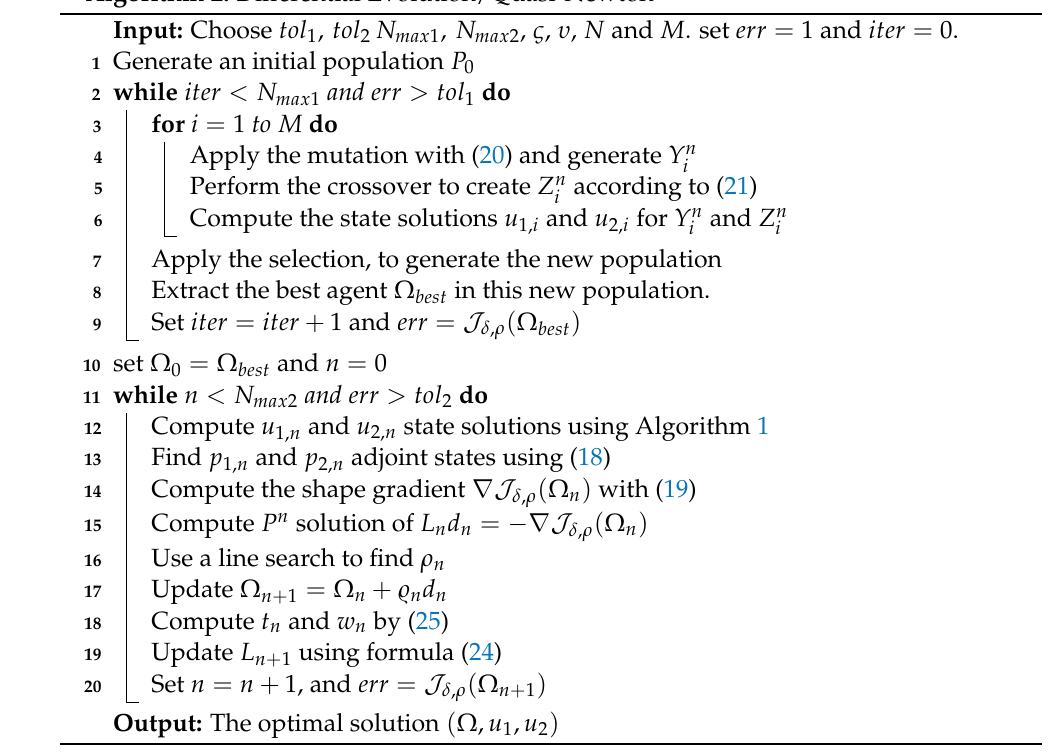
Algorithm 2: Differential